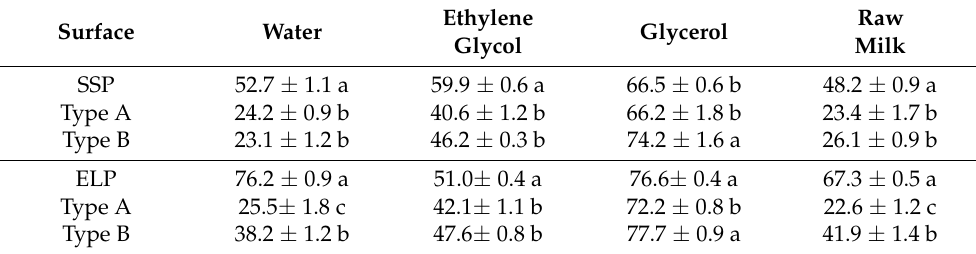
Table 3. Contact angle for different model liquids on SSP and ELP with and without deposits.